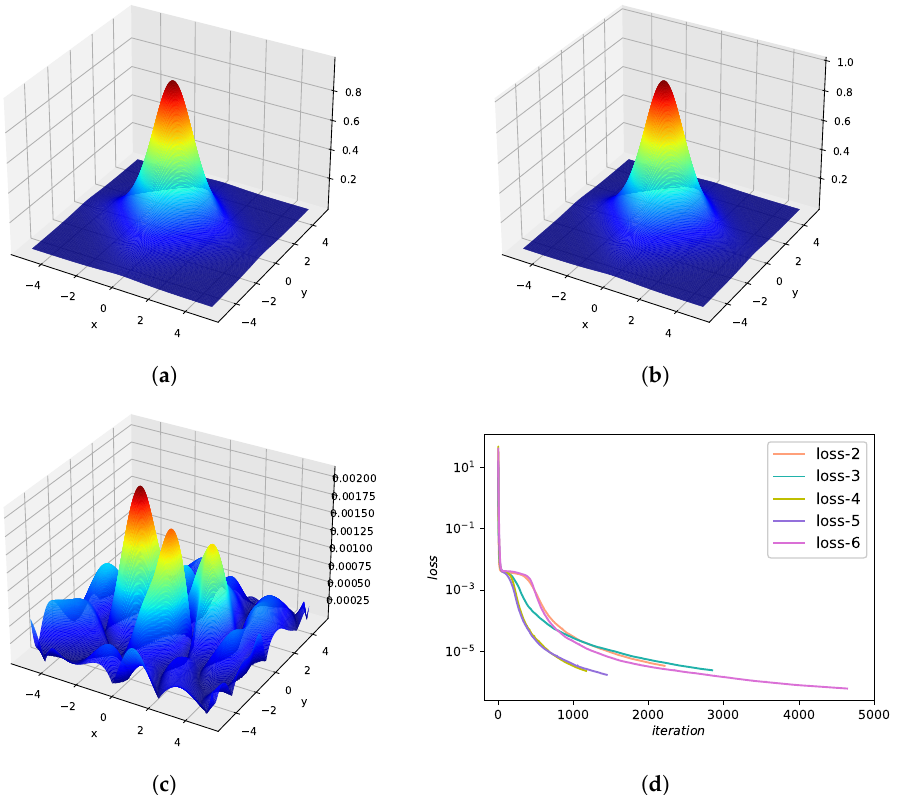
Figure 17. Results of Equation (58). ( a ) Exact solution at time t = 0.1. ( b ) Predicted solution at time